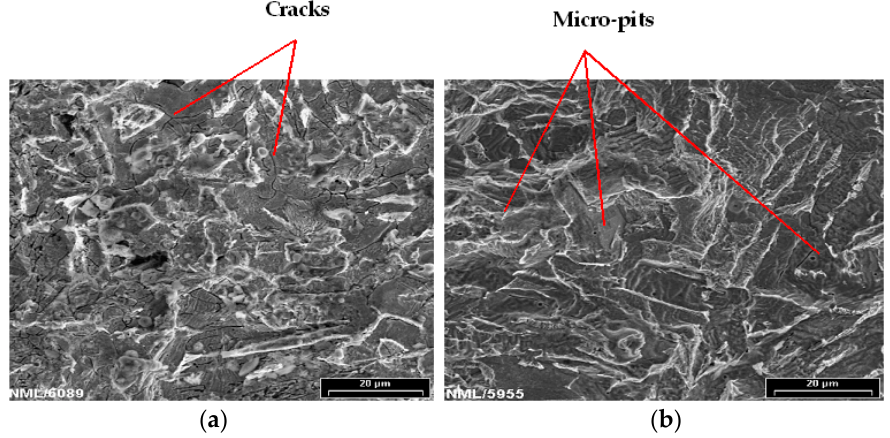
Figure 6. Post-corrosion scanning electron microscope (SEM) images of MAS at 1000× after 60 days immersion in ( a ) E80 + 0 mg/L NaCl with cracks present; and ( b ) E80 + 32 mg/L NaCl showing micro-pits.